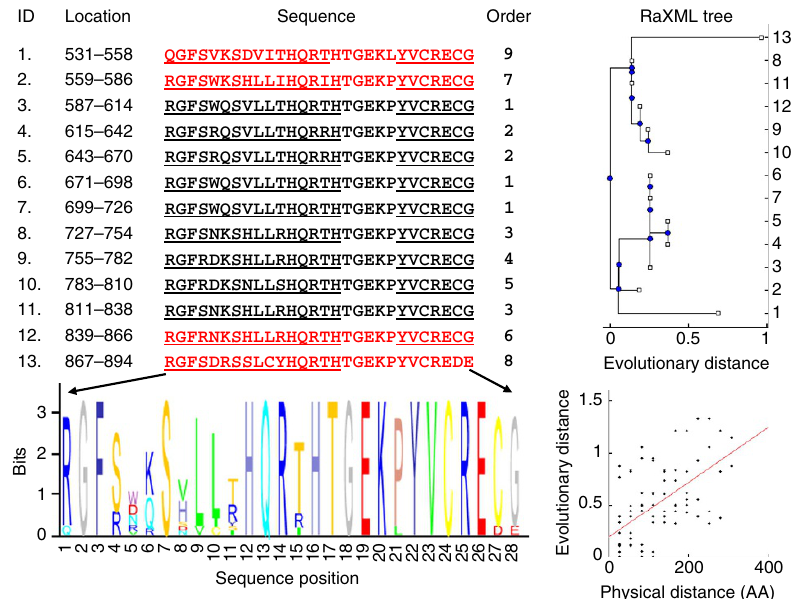
Figure 2 | Example of analysis of a single protein, the 894AA long human zinc-finger PRDM9 . The 13 tandemly 28AA long repeats (ID) are identified by the algorithm at the end of the protein, ordered by their location on the protein. Underlined letters correspond to the Zinc fingers annotated in SwissProt (first finger starts 7AA before the beginning of the first repeat). The order by which the method accumulates the repeats (Order), reveals clusters of identical repeats: 1 (ID ¼ 3,6,7), 2 (ID ¼ 4,5) and 3 (ID ¼ 8,11). Black coloured repeats represent the seed identified in the second step, and red coloured repeats are those identified by the PPM-based predictor in the third step. Repeats are highly similar, with high IC, as shown by the sequence logo. A maximum-likelihood tree of the repeats is shown in the right panel, where the repeats IDs are given on the y axis. The plot beneath the tree shows the positive correlation between evolutionary distance (in substitutions per site) and physical distance (in amino acids), obtained by comparing all repeat pairs, where the red line represents a linear regression fit (Spearman correlation ¼ 0.53, P value ¼ 6.7e (cid:2) 7). The mean d N/ d S for all pair comparisons ( n ¼ 78 ): o d N/ d S 4 ¼ 2.7146 ± 0.23, that is, significant positive